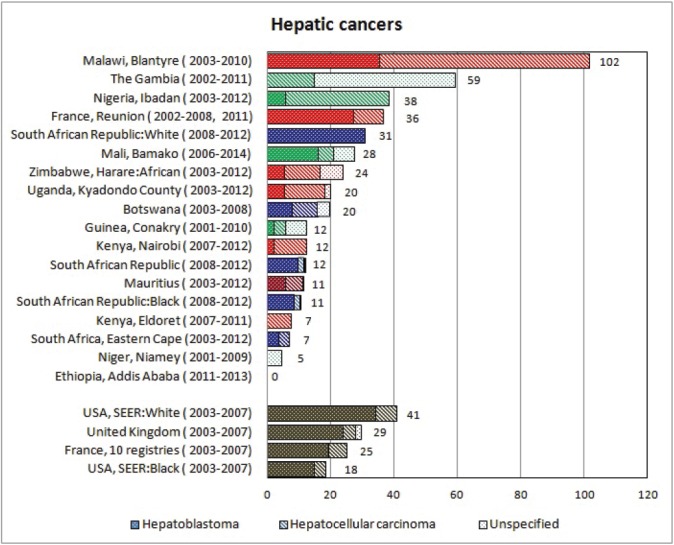
Cumulative (0–14) incidence rate—hepatoblastoma, hepatocellular carcinoma and others.